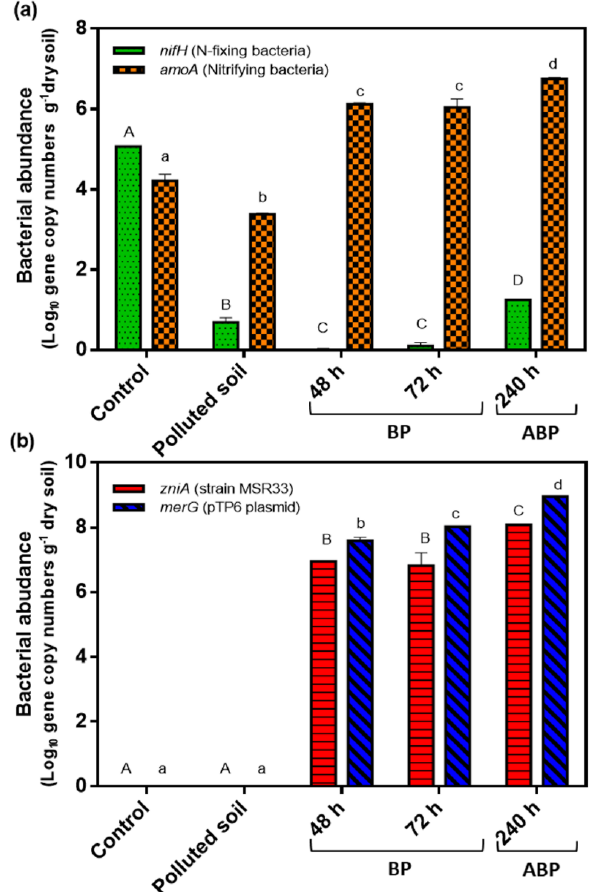
Figure 7. Effects of mercury (II) (20 ppm) and mercury bioremediation on gene copy numbers of nifH